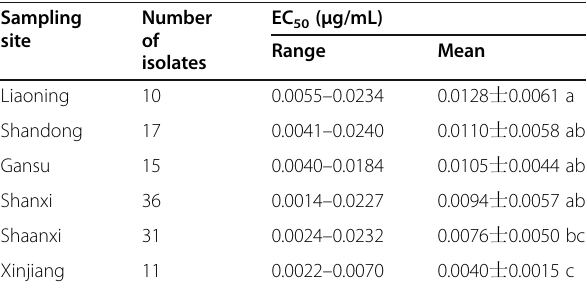
Table 1 Sensitivity to pyraclostrobin of Valsa mali field isolates from different locations in